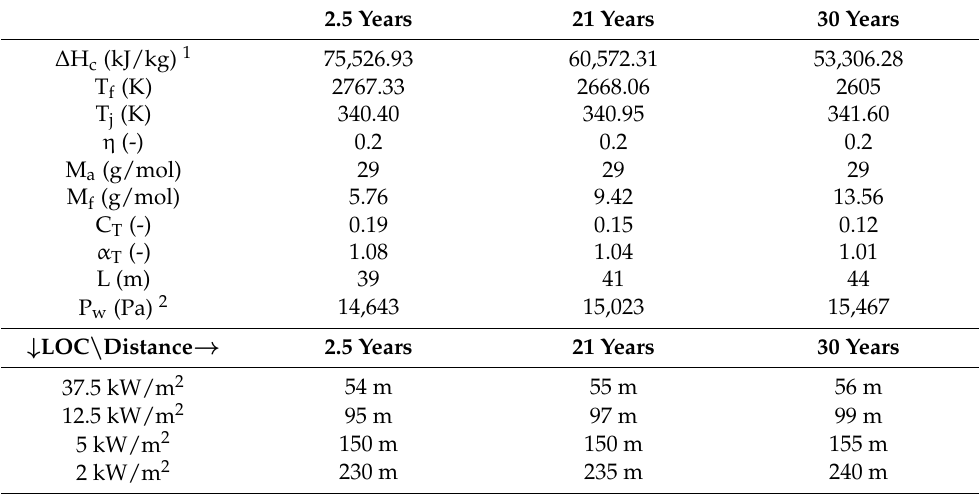
Table 5. Jet fire calculation results, thermal radiation level of concern (LOC) [50] and relative distance downwind at 2.5, 21 and 30 years.